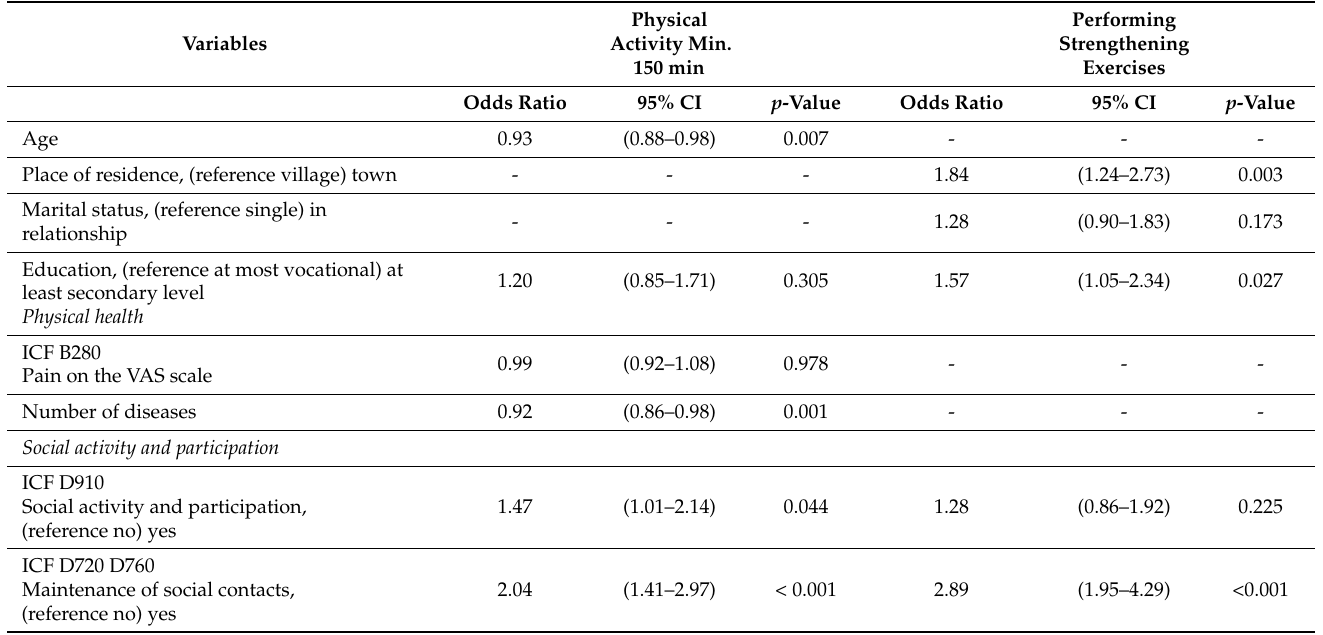
Table 4. Logistic regression models illustrating factors influencing the undertaking of physical activity, min. 150 min/week, and performing strengthening exercises of people aged 75–90 years ( n =